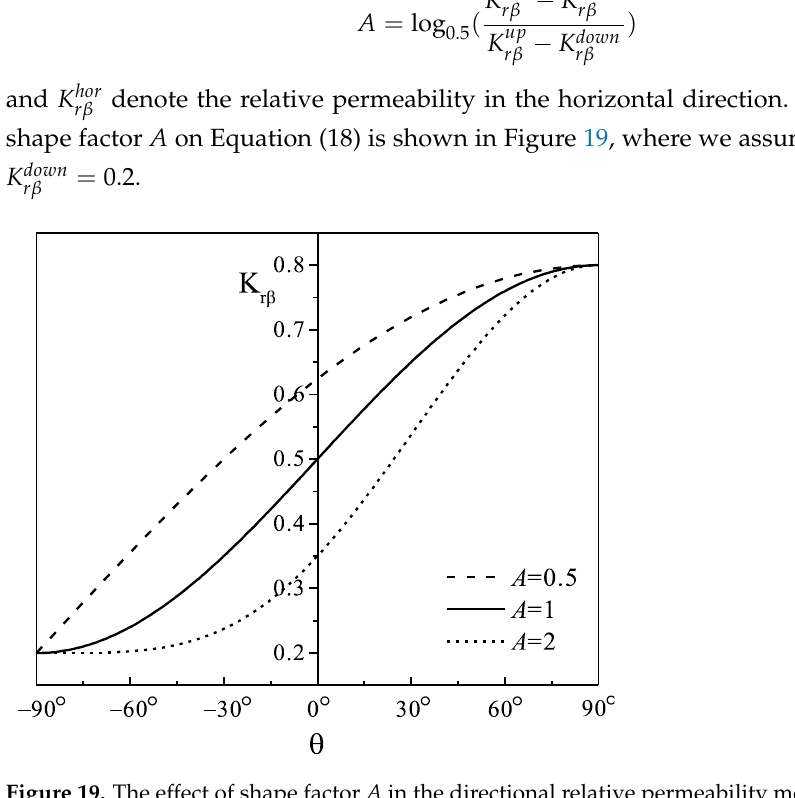
Figure 19. The effect of shape factor A in the directional relative permeability model Equation (18). According to the model, if the relative permeability curves for fluid flow in vertically downward, horizontal, and vertically upward directions (which can be determined either by physical experiment or numerical simulation) were known, the relative permeability curves in any other direction could be predicted by the proposed model. To validate this directional relative permeability model, the relative permeability of the single-vug model at several dimensionless water saturations ( S ∗ = 0.2, 0.4, 0.6, and 0.8) are predicted and w compared to the relative permeability calculated by the upscaling method in Section 4.2. Due to symmetry, only the half curves for the water phase and oil phase are given in Figures 20 and 21, respectively. It can be seen that the proposed model is able to accurately predict the relative permeability value in different directions for the single-vug